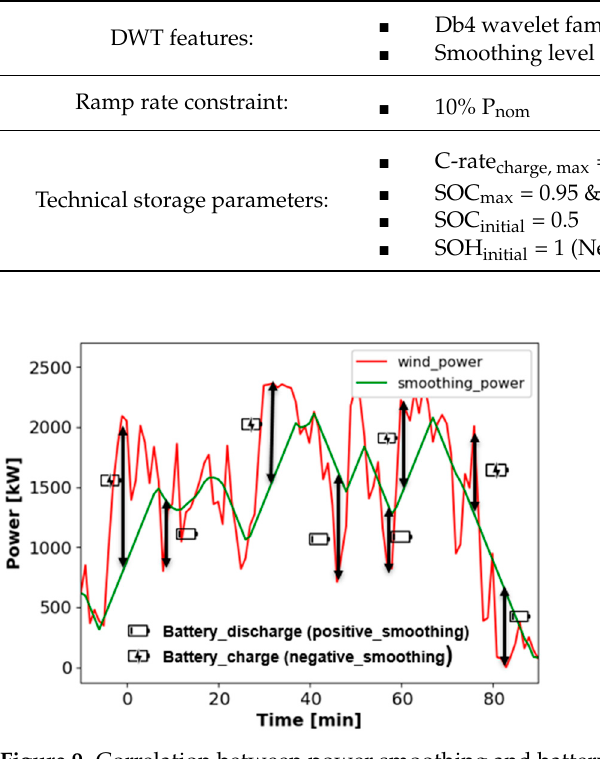
Figure 9. Correlation between power smoothing and battery operation mode for a demonstrative time frame.